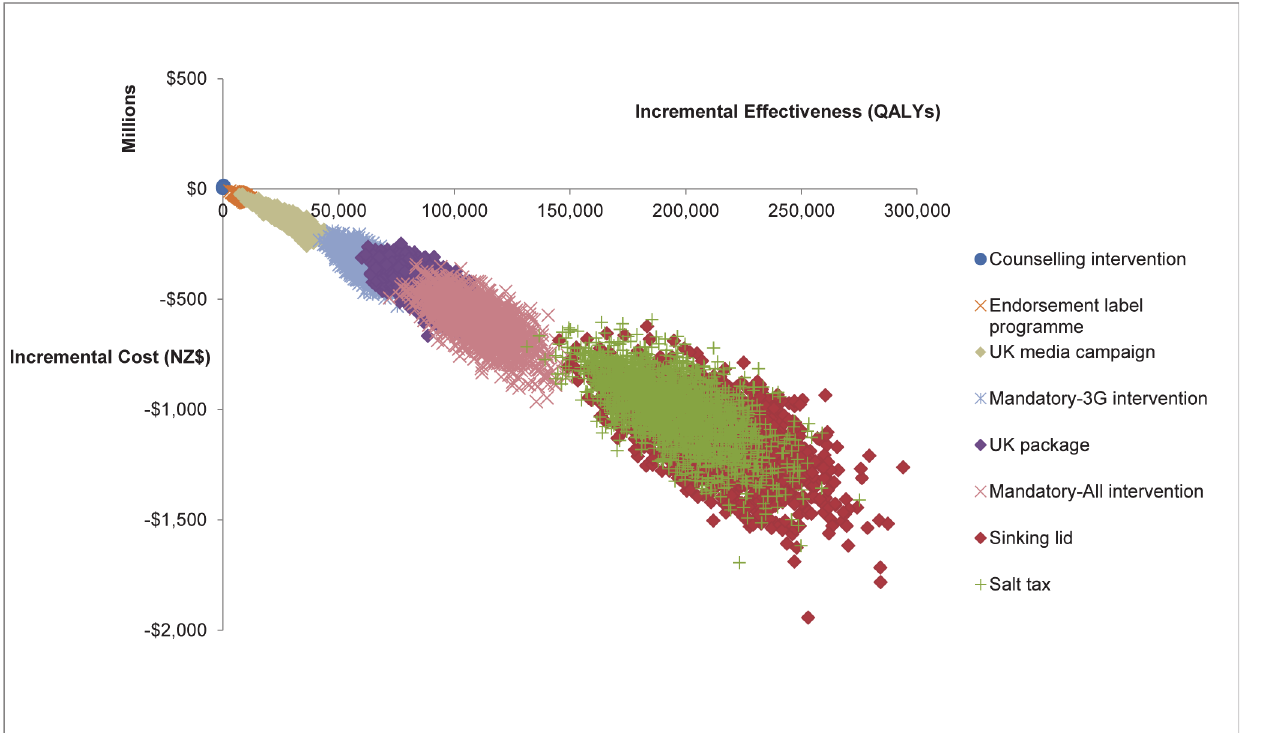
Fig 1. Cost-effectiveness plane with the eight salt-reduction interventions for the New Zealand adult